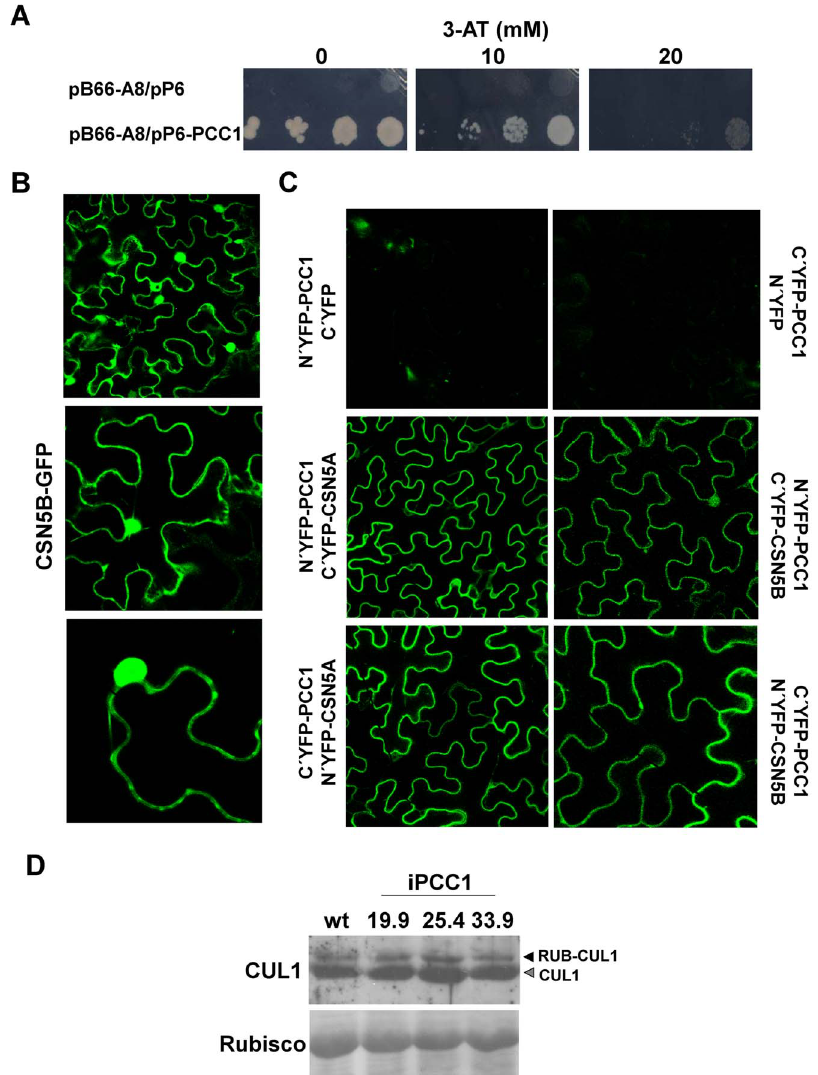
Figure 7. Functional interaction between PCC1 and the subunit 5 of the COP9 signalosome. (A) Growth in -Leu-Trp-His media of yeasts co-transformed with clone A8 corresponding to CSN5B subunit of COP9 signalosome fused to the GAL4 activation domain (pB66-A8) and either PCC1 fused to the GAL4 DNA binding domain (pP6-PCC1) or the empty vector (pP6). Growth was tested in increasing concentration of 3-aminotriazol (3- AT). (B) Subcellular localization of CSN5B in cytoplasm and nucleus of Nicotiana benthamiana leaves transformed with 35S::GFP-CSN5B . (C) Interaction of PCC1 with CSN5A and CSN5B in the plasma membrane as demonstrated by BiFC in Nicotiana benthamiana leaves transiently co-transformed with the indicated constructs. (D) Levels of free and rubylated (RUB-) forms of CUL 1 in wt and iPCC1 plants as shown by Western blot with anti-CUL1 polyclonal antibodies. Ponceau S-stained Rubisco is shown as loading control.